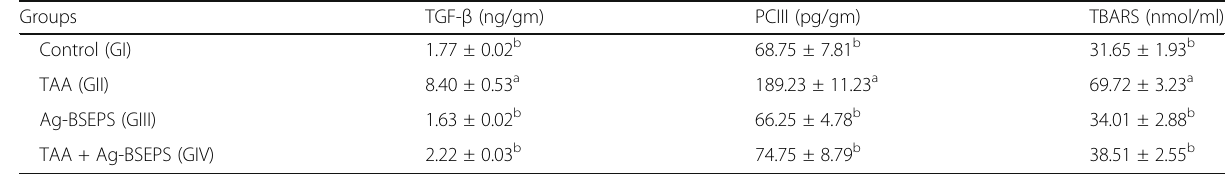
Table 2 Effect of Ag-BSEPS on some of fibrotic markers, and TBARS in control and experimental rats Groups